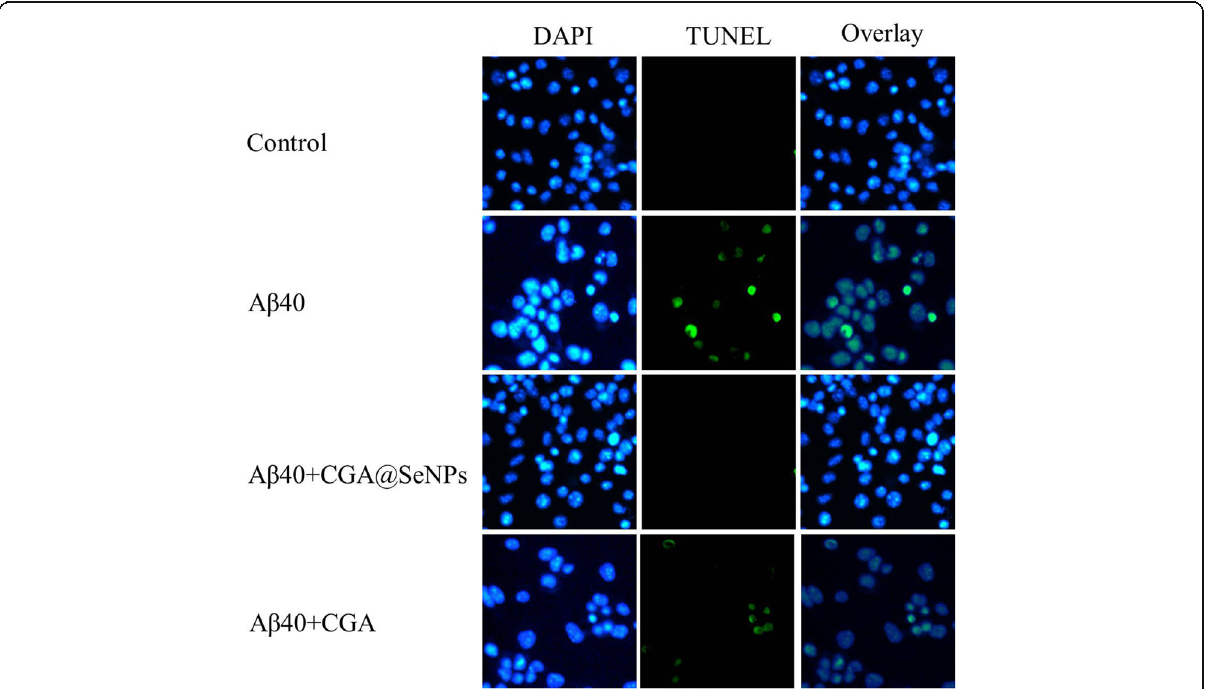
Fig. 6 CGA@SeNPs prevent A β 40-induced cell apoptosis in PC12 cells. Cell apoptosis was detected by TUNEL-DAPI co-staining assay. Normal cell nucleus was stained in blue, and DNA fragment was stained in green. A β 40 = 35 μ M, CGA@SeNPs/CGA = 60 μ